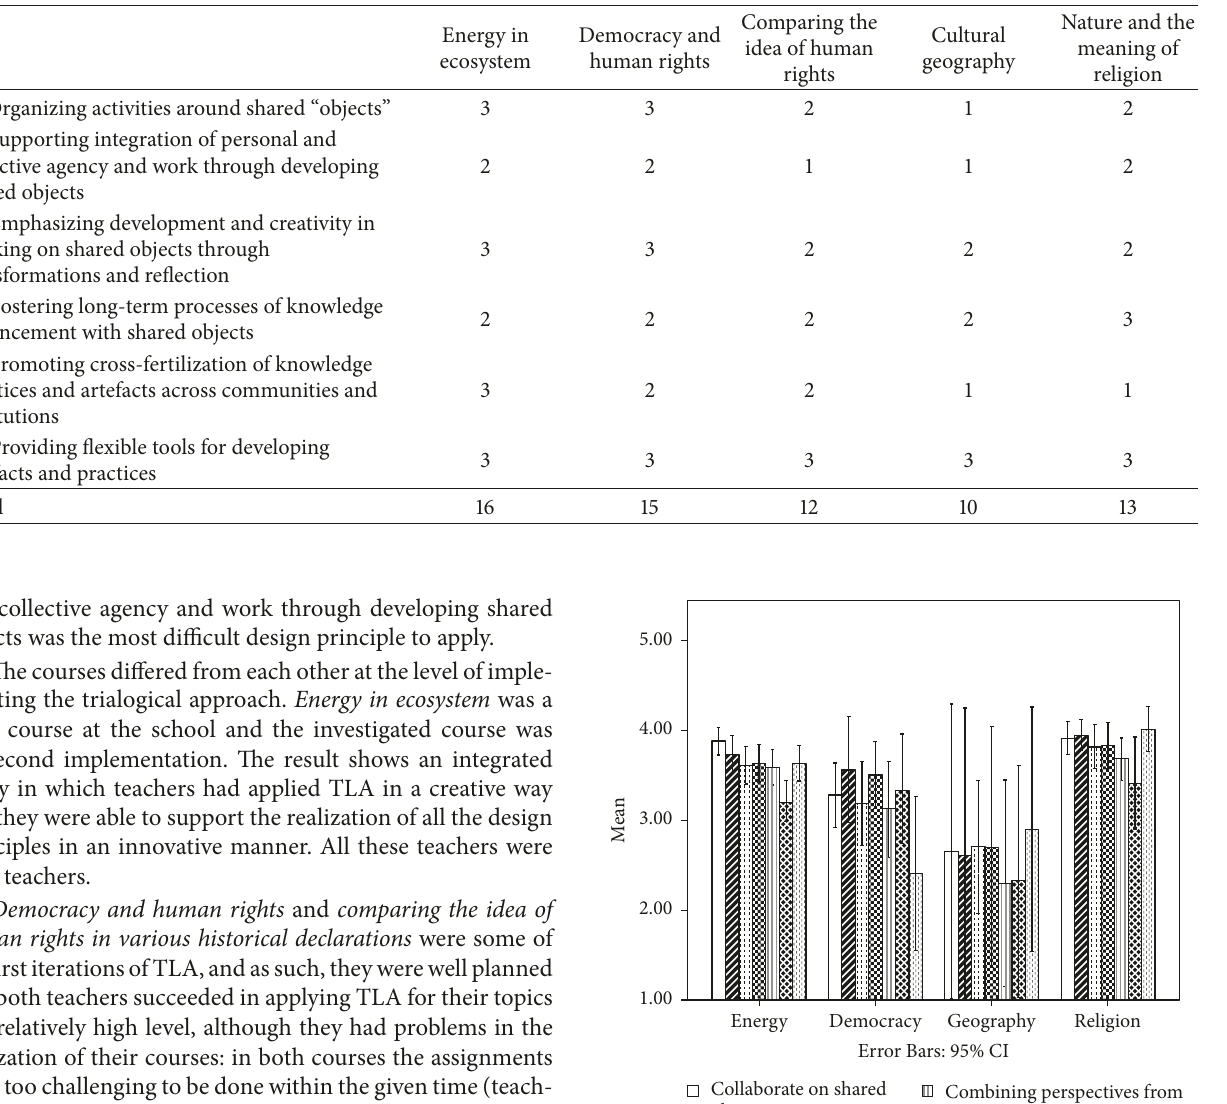
Table 4: The level of trialogical design principles applied in five courses.